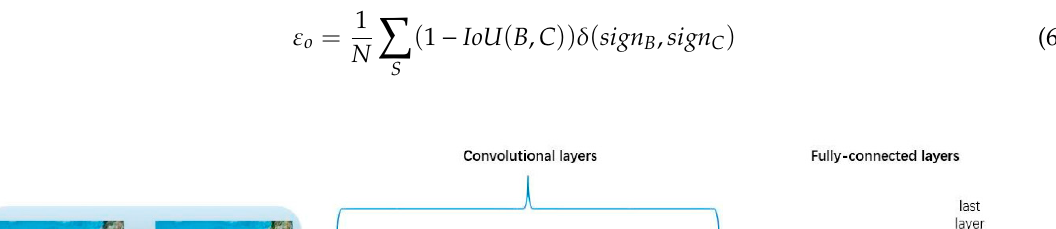
Figure 8. Twenty categories. A total of 10,582 training images and a VOC2012 validation set containing a total of 335 images remained unchanged in this work. 4.2. Parameter Sensitivity of Regional Combination In order to assess the performance of the superpixel region merging algorithm, we studied the effects of different parameters, for instance, the weight size, the number of super-pixels, and the amount of regions after fusion on the segmentation results. We tested on the VOC 2012 dataset, the standard metric [42] is the boundary recall (BR) and the achievable segmentation accuracy (ASA). The boundary recall measures the percentage of the natural boundaries recovered by the superpixel boundaries while the achievable segmentation accuracy gives the highest accuracy achievable for object segmentation that utilizes super-pixels as units [42]. Figure 9 reveals the performance changes for different shape parameter α . In respect of BR, the monotonic value of BR reduces. When α ≤ 0.2, there is only a slight change. In the case of BR and ASA, the curve trend is nearly similar and both decreasing as the amount of pixels increases, and the value of α increases as well. In order to make the number of super-pixels as consistent as possible and avoid significant reduction of the segmentation precision, we set 0.3 ≤ α ≤ 0.9. Also, the number of super pixels is controlled at 600–1500.